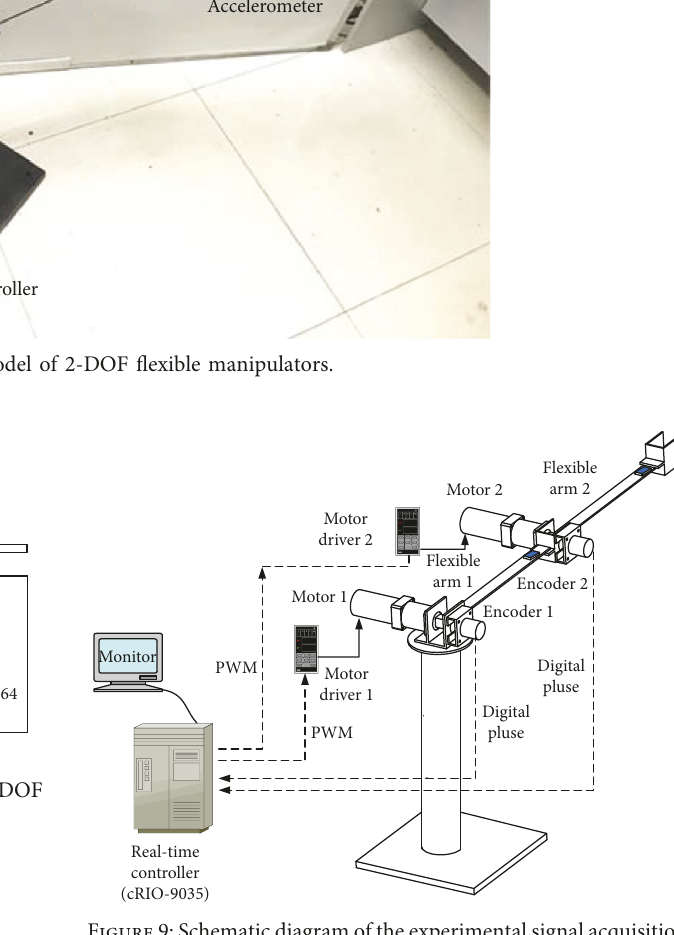
Figure 9: Schematic diagram of the experimental signal acquisition and